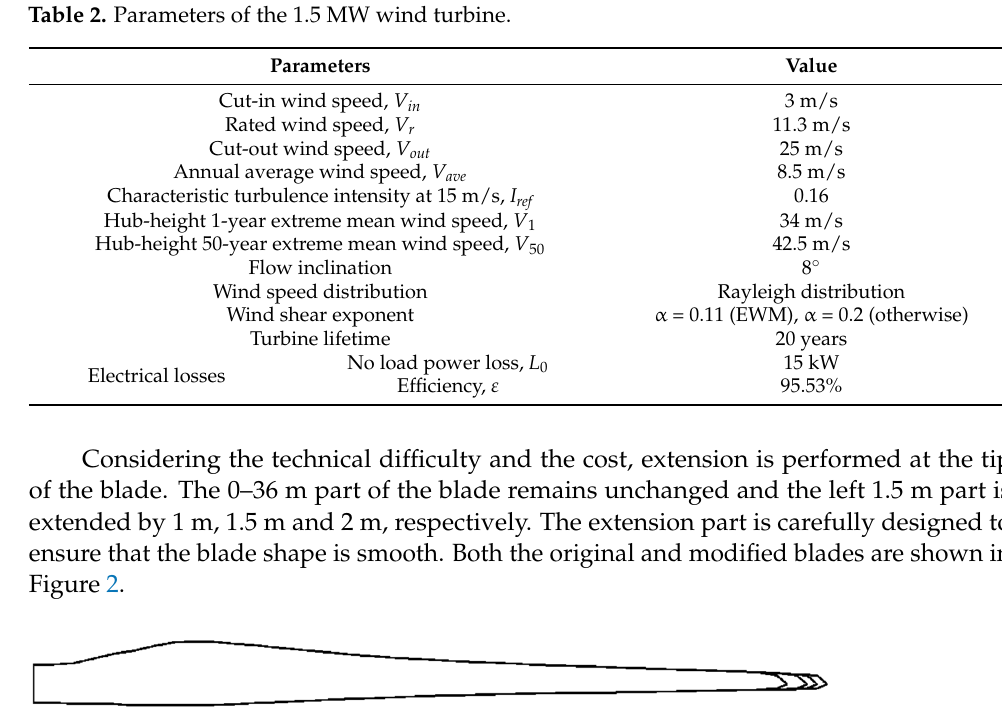
Table 2. Parameters of the 1.5 MW wind turbine.